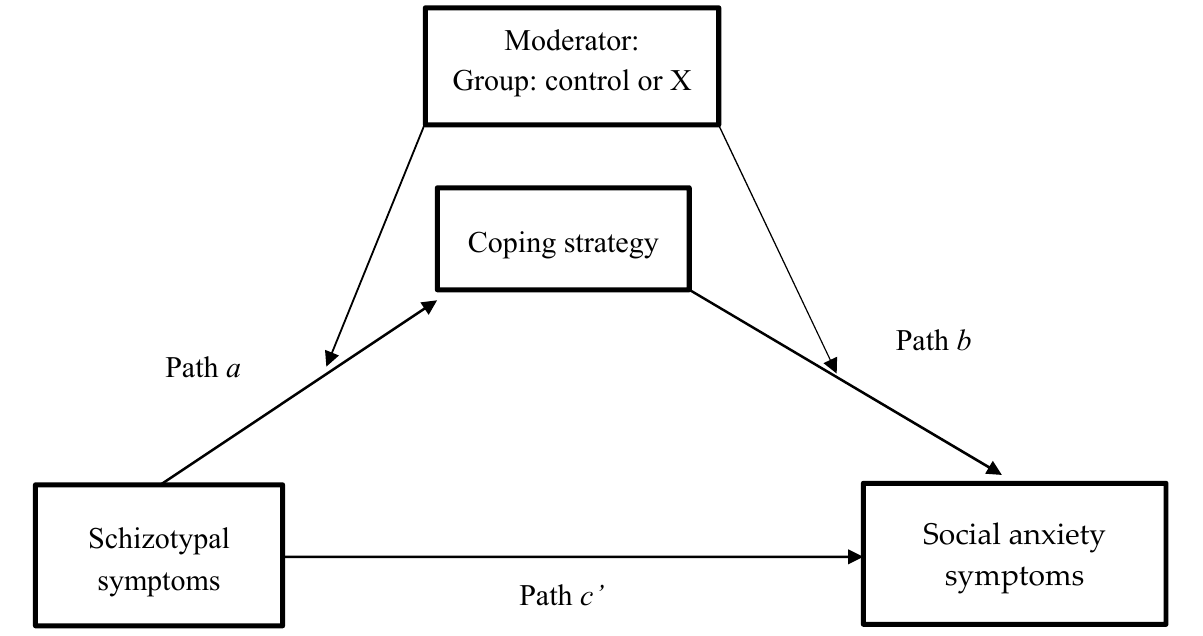
Figure 1. Diagram of the moderated mediation model with coping strategy as the mediator and group as the moderator (model 58).